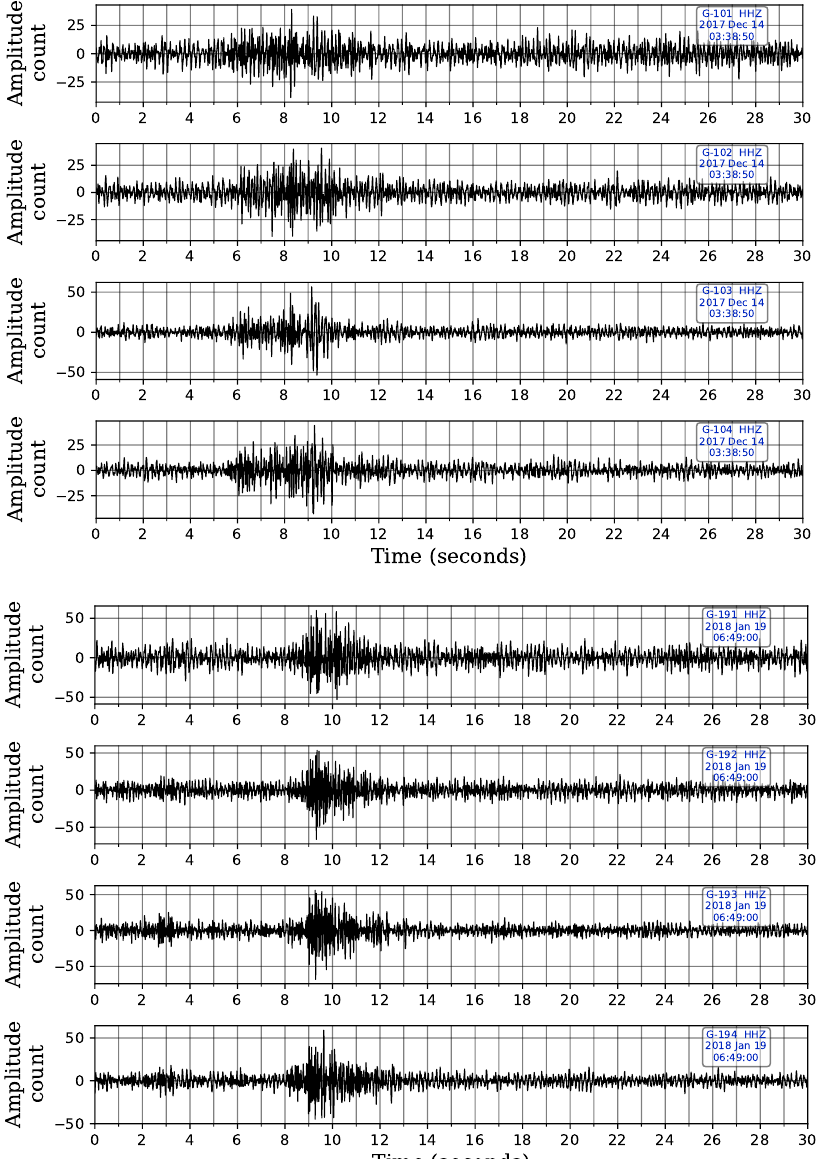
Figure 8. Z-component waveforms at the four sensor levels for stations G10 and G19 from two of the uncataloged events picked by our trained CNN model. These two events were neither picked by STA/LTA nor template matching. Picking of these two events, despite their low-magnitude and relatively low SNR data, shows the efficacy of the trained CNN model. The waveforms are displayed in sequence for each station, with the waveform from the shallowest sensor at the top and the one from the deepest sensor at the